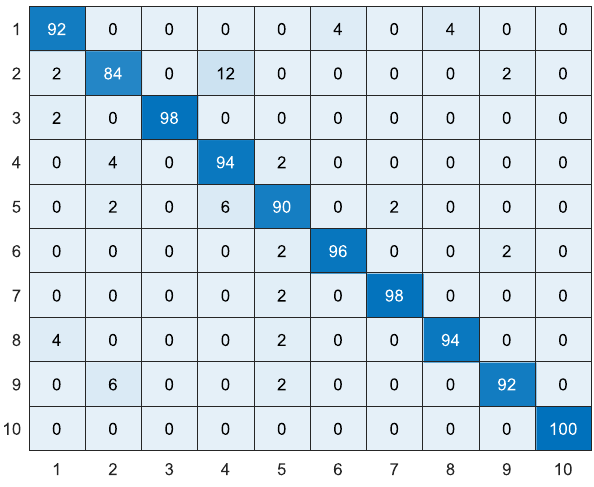
Figure 13. The confusion matrix obtained by WTLD_kirsch with SVM of RBF kernel function (%).